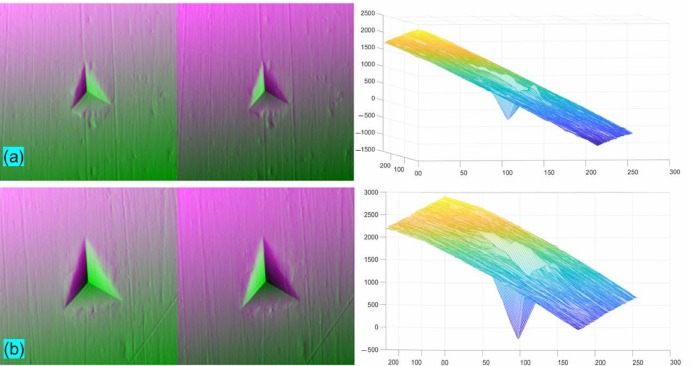
Figure 7. Predicted 2D (forward and reverse) and 3D topographic image for new test parameters from the table provided by the user ( a ) Sl. No. 7: load: 1730 µ N, time: 140, and ( b ) Sl. No. 17: load: 3900 µ N, time: 230